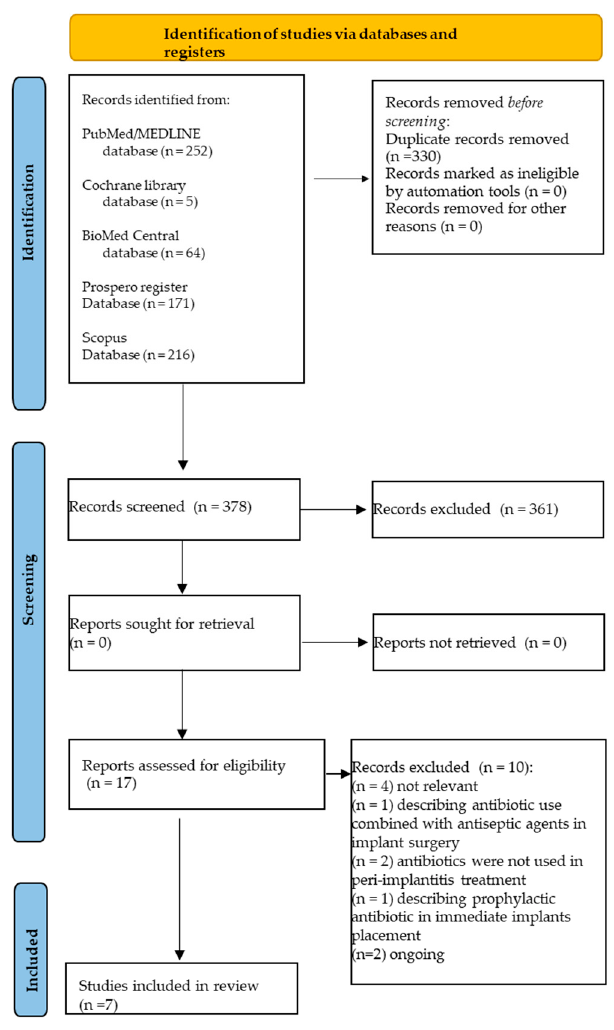
Figure 1. Study selection flowchart.